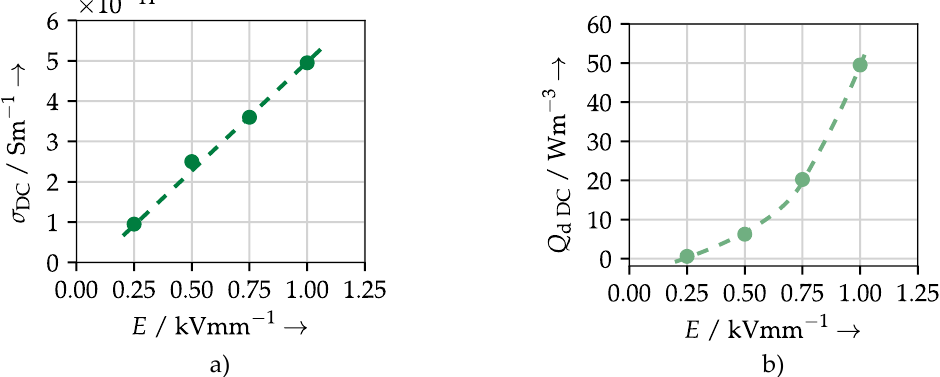
Figure 5. ( a ) Measured DC conductivity and ( b ) calculated heat source density as a function of the electric field strength, one f-SiR sample.